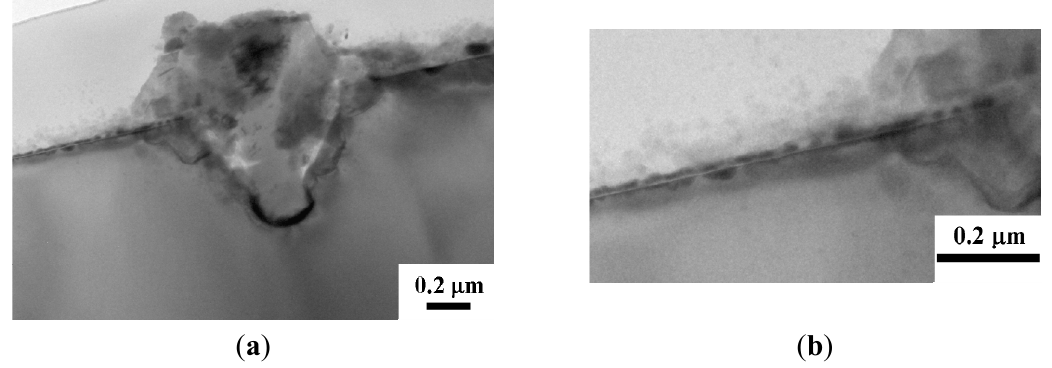
Figure 7. ( a ) TEM cross section views for the MgO (3 nm) sample annealed for 5 min at 800 °C; ( b ) Enlarged view of the left part of ( a ).